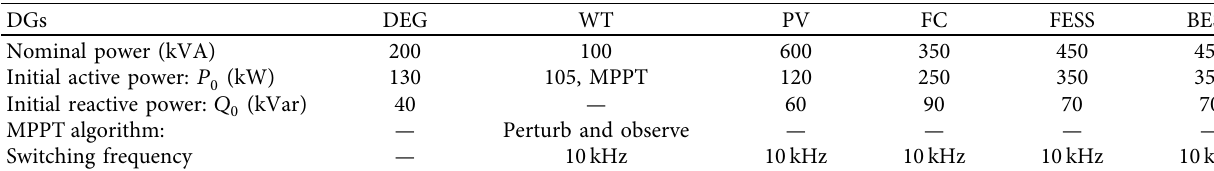
Figure 18: Power output of DG units: (a) output power of the units when the proposed control scheme is utilized and (b) output power of the units when the optimal PI presented in [37] is employed. Table 5: Design